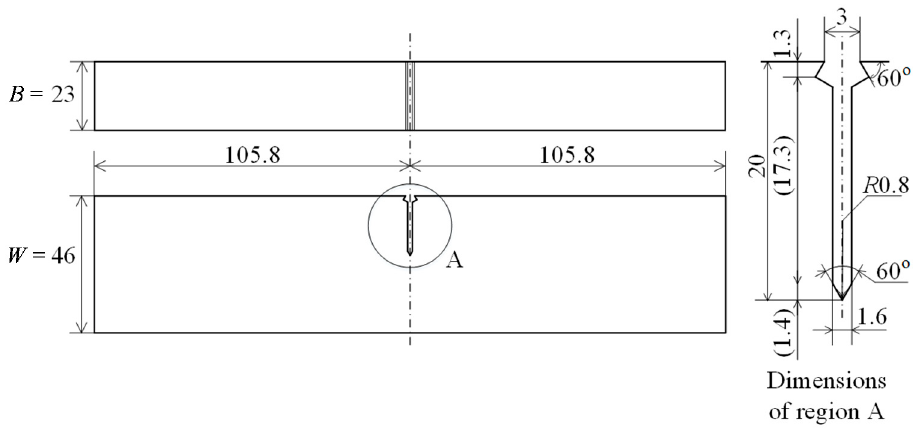
Figure 9. Dimensions of SE(B) fracture toughness test specimen used for S45C. All the dimensions are in millimeters. The support span was 4 W , where width W = 46 mm.